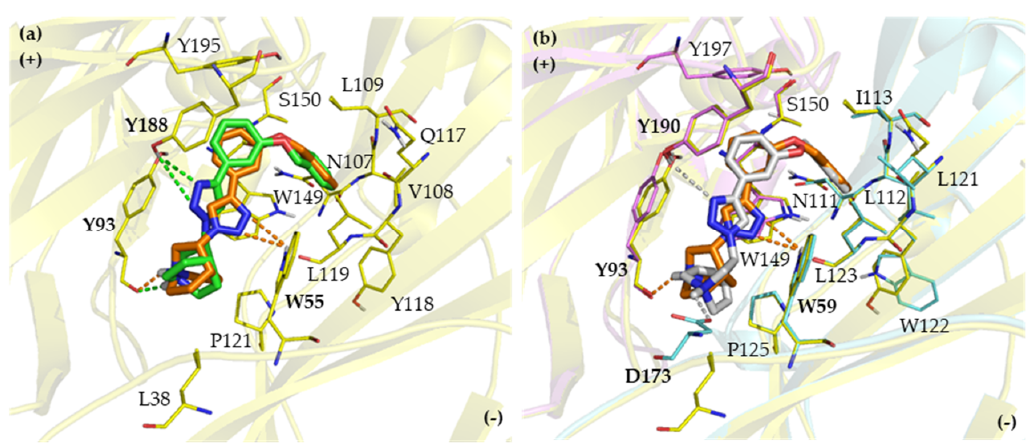
Figure 8. ( a ) The overlay docking poses of ( R )-T5 (orange) and ( S )-T5 (green) in the binding site of the α7 nAChR and ( b ) the overlay of ( R )-T5 docking poses in the α7 (orange) and the α3β4 nAChR (grey).The amino acid residues in Figure 8a represent the α7 homology model, whereas the amino acid residues in Figure 8b belong to the α3β4 nAChR subunit. The bold letters show amino acids having hydrogen bond interactions. The polar hydrogen atoms of the amino acid side chains are displayed to identify hydrogen bond donors and acceptors. Yellow, α7 subunit; pink, α3 subunit; cyan, β4 subunit; red, oxygen; blue, nitrogen.